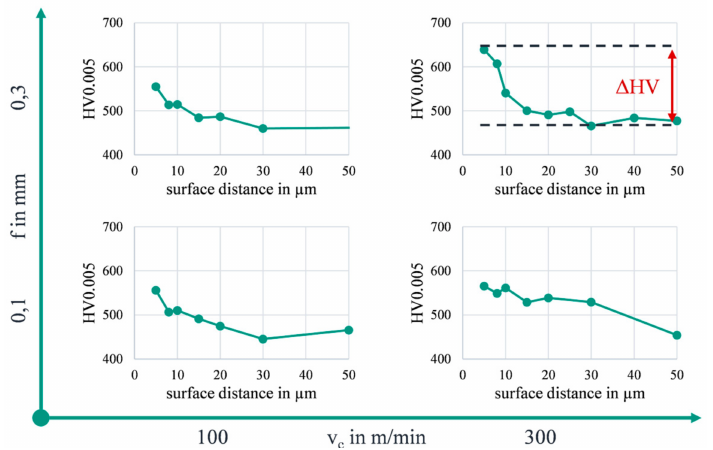
Figure 4. Microhardness depth profiles when turning AISI 4140 QT, tempered at 450 ◦ C, with